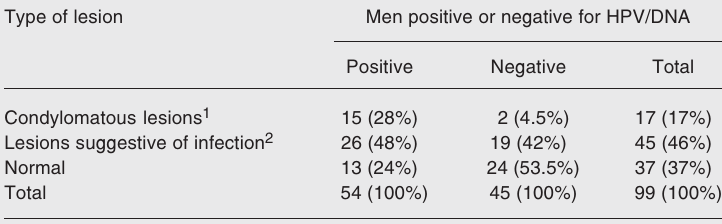
Table 1. Number and percentage (in parentheses) of men positive or negative for human papillomavirus (HPV) DNA and the type of their lesions as detected by peniscopy.